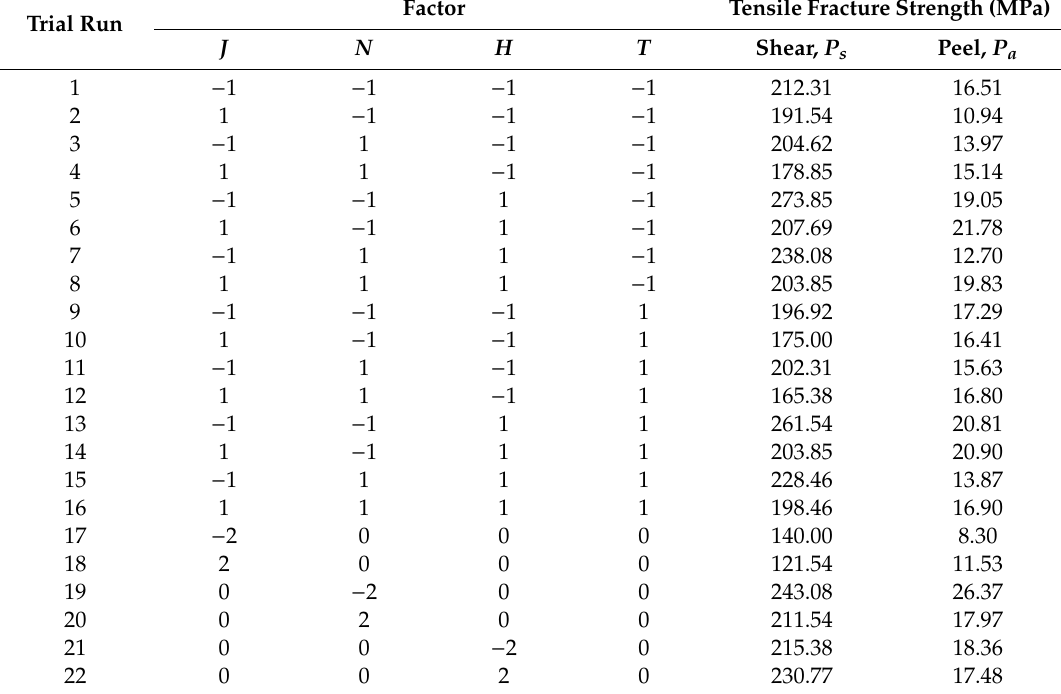
Table 5. CCD matrix and experimental